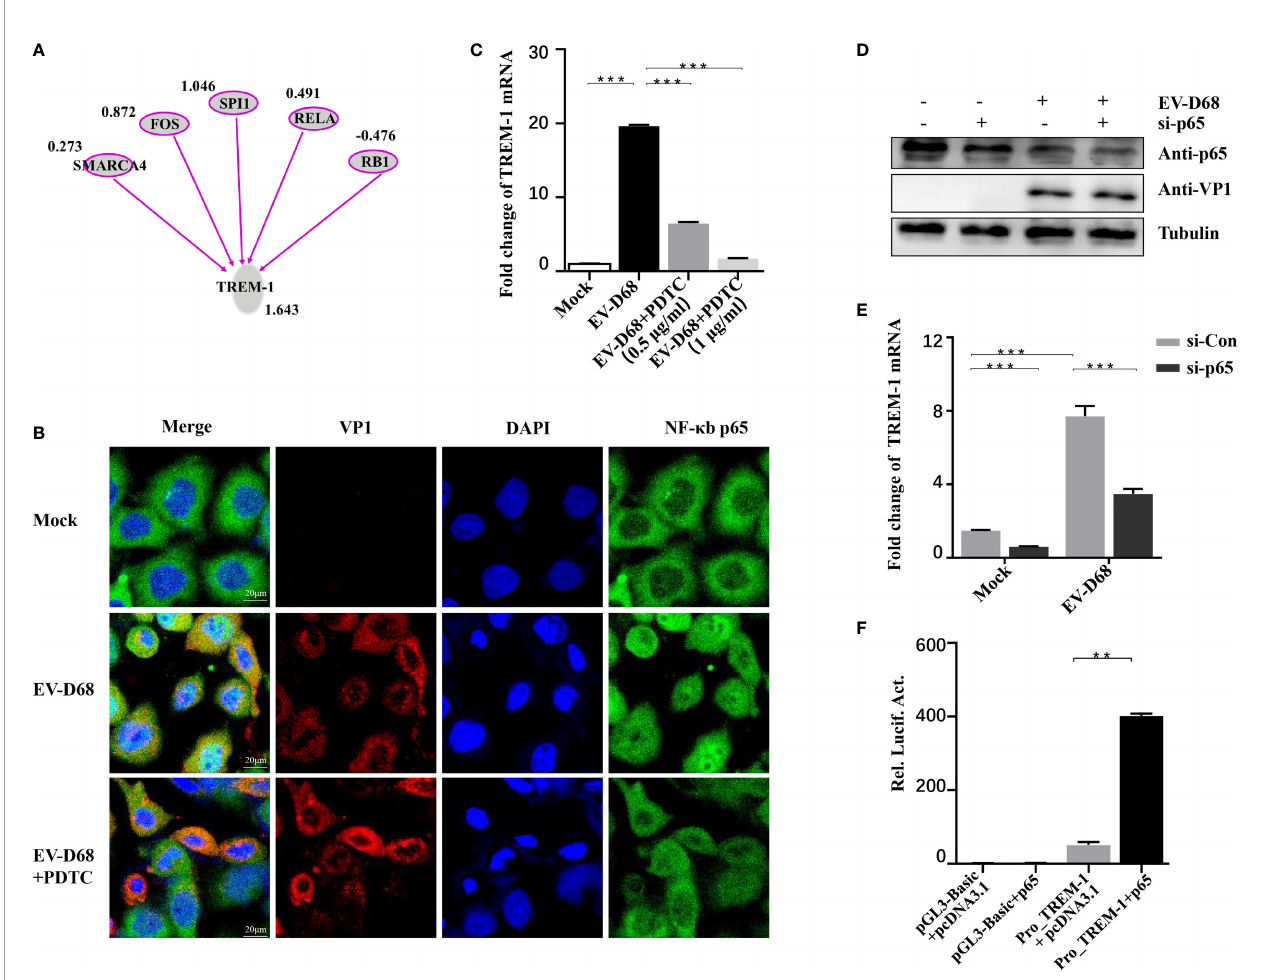
FIGURE 6 | TREM-1 induction by EV-D68 is dependent on NF- k B p65. (A) Analysis of TREM-1 upstream regulators using IPA. (B, C) Hela cells were pre-incubated with PDTC (500 ng/ml, 48-well plates) for 2 h and EV-D68 was added (MOI = 0.1) for 24 h. A laser confocal microscope was used to observe p65 nuclear import and RT-PCR analysis was performed to measure TREM-1 mRNA abundance. The GAPDH gene served as an internal control. (D, E) HEK-293T cells were transfected with si-p65 (100 nM) for 24 h, and then infected with EV-D68 (MOI = 0.1). SDS-PAGE analysis was conducted to measure NF- k B p65 expression levels (D) and qPCR was performed to measure TREM-1 mRNA levels (E) . The GAPDH gene served as an internal control. (F) NF- k B p65 or pcDNA3.1 was cotransfected with Pro_TREM-1 or pGL3-Basic in HEK293T cells (24-well plate). Empty vectors pGL3-Basic and pcDNA3.1 were used as controls, and all cells were transfected with pRL-SV40 as an intracellular reference. After 48 h, a dual-reporter detection system was used to measure luciferase expression levels of different groups. ** p < 0.01, *** p <